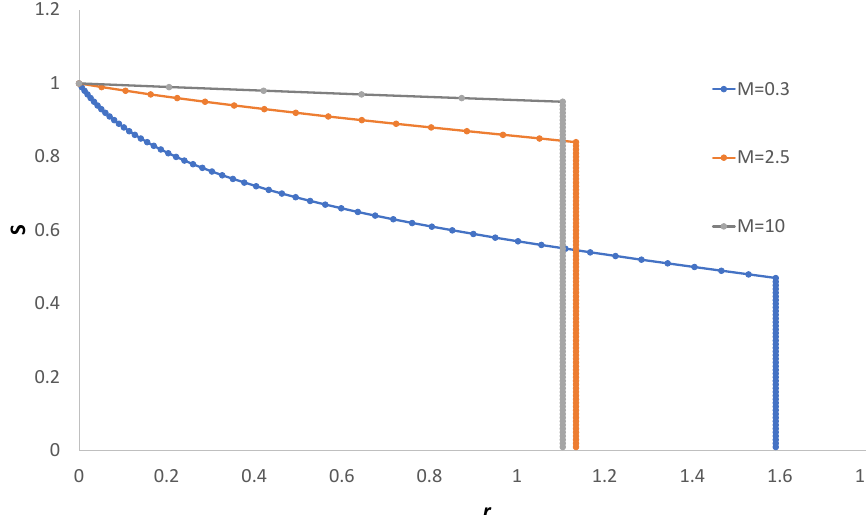
Figure 10. The velocity of the propagation front for the three mobility